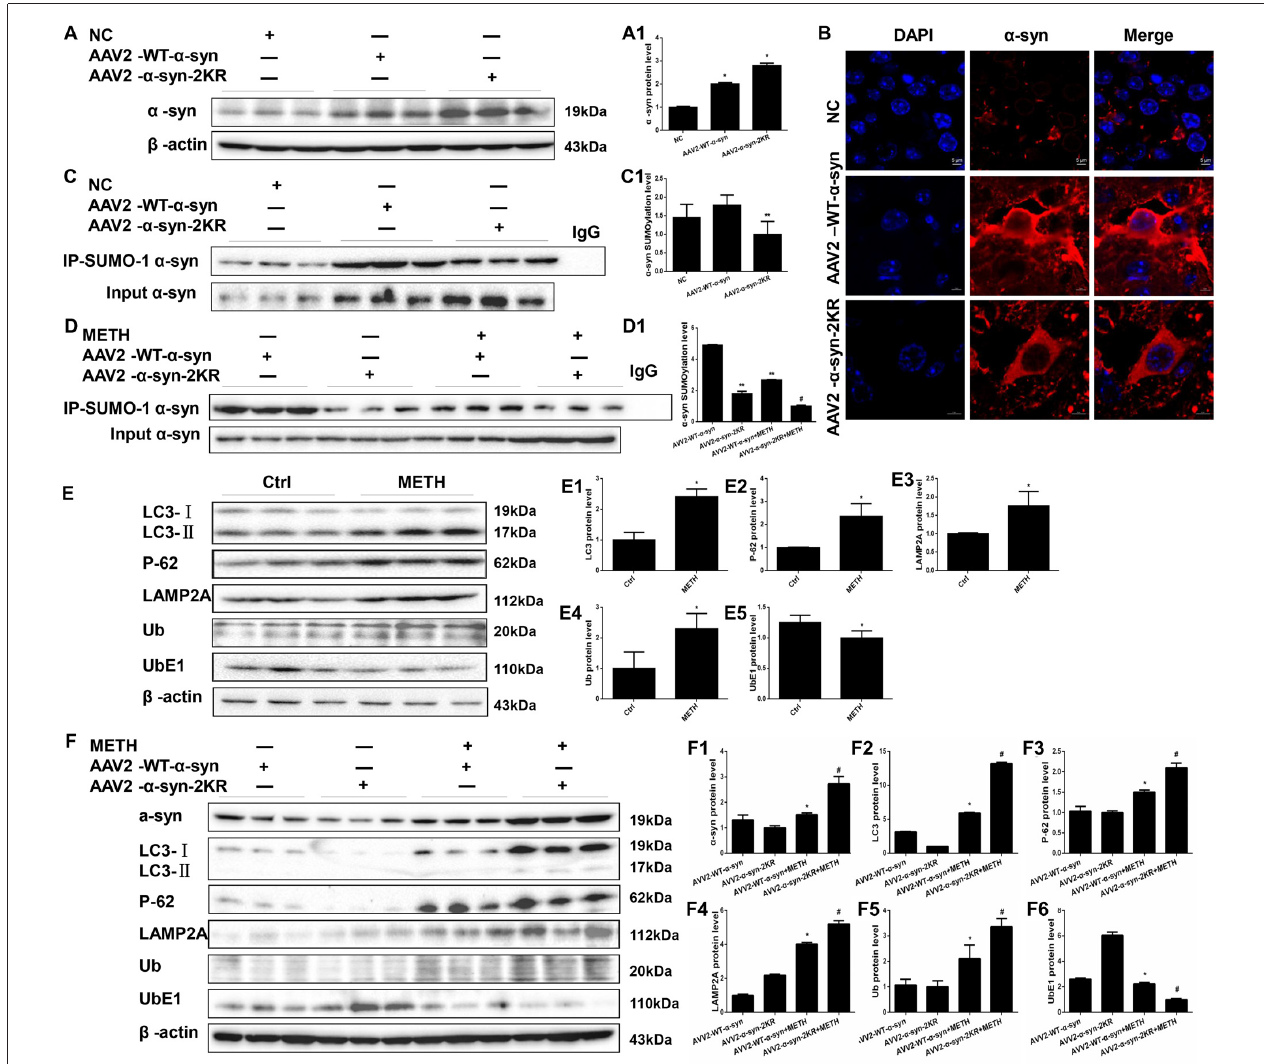
FIGURE 8 | Mutations in the major SUMOylation acceptor sites of α -syn exacerbate METH-induced α -syn aggregation in vivo . Adenovirus were injected into the right striatum of mice using a standard stereotaxic positioning system. After 2 days of recovery, mice received saline or METH by i.p. injection. Striatal tissues (right side) were harvested at 24 h after the injection of the last dose. The tissues were immunoprecipitated with an anti-SUMO-1 antibody, followed by western blot with an anti- α -syn antibody. Tissues immunoprecipitated with IgG were used as a negative control. Western blot (A,C) and quantitative analyses (A1,C1) were performed to evaluate the efficiency of WT α -syn and α -syn-KR expression. Immunofluorescence staining of mouse striatum sections showed that α -syn expression increased after injection of adenovirus (B) . Western blot (D–F) and quantitative analyses (D1,E1–5,F1–6) were also performed to the levels of the SUMO-1, UbE1, Ub, LC3-II, P-62 and lysosomal associated membrane protein 2A (LAMP2A) proteins and the expression of SUMOylated α -syn. β -Actin was used as a loading control. ∗ p < 0.05 compared with the AAV2-NC or control group. ∗∗ p < 0.05 compared with the AAV2- α -syn group. # p < 0.05 compared with the AAV2- α -syn + METH-treated group. The data shown in (A,C,D,F) were analyzed using one-way ANOVA followed by LSD post hoc analyses, whereas the data shown in (E) were analyzed using the Mann-Whitney U test.